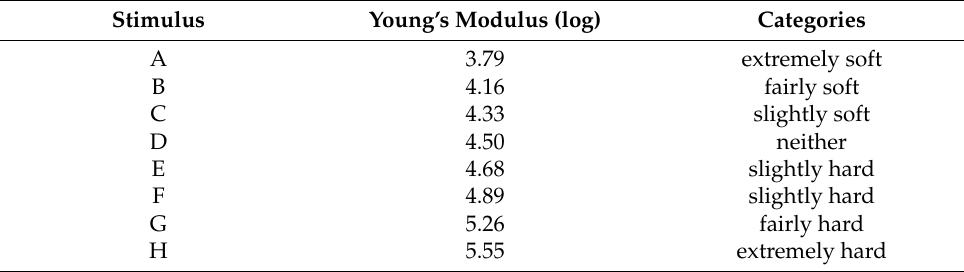
Table 1. Stiffness of the test pieces used in the experiment.